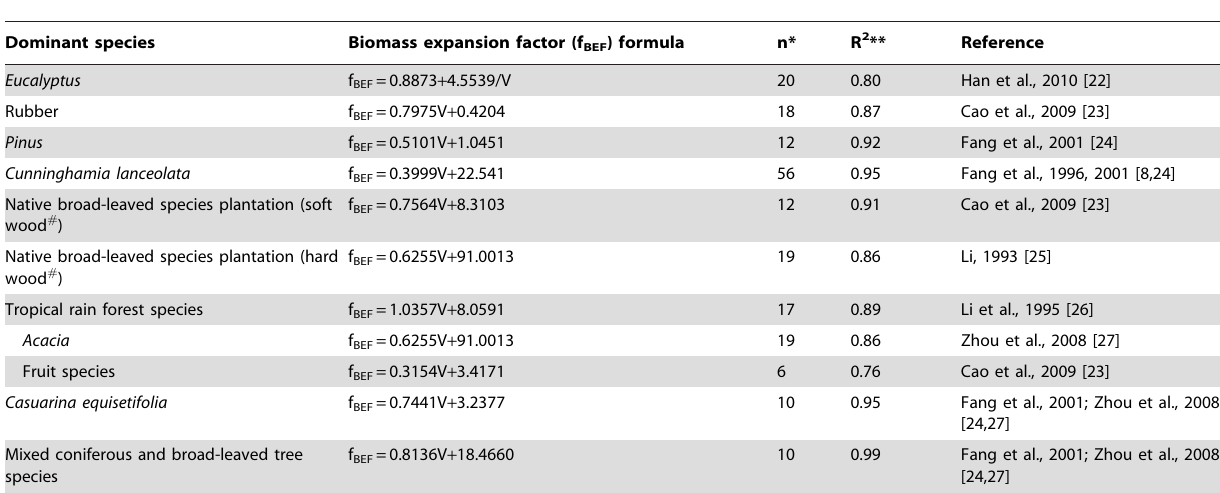
Table 1. The conversion formulas used in previous studies for estimating the biomass of dominant tree species on Hainan Island.